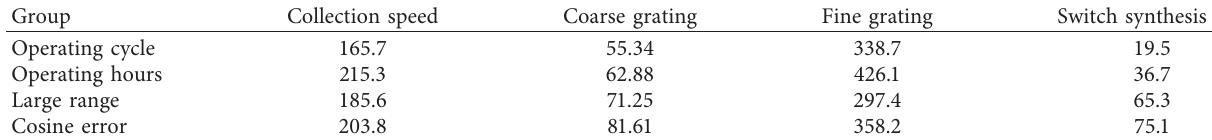
Table 2: Cosine error of displacement measurement system of nanoscale grating ruler.